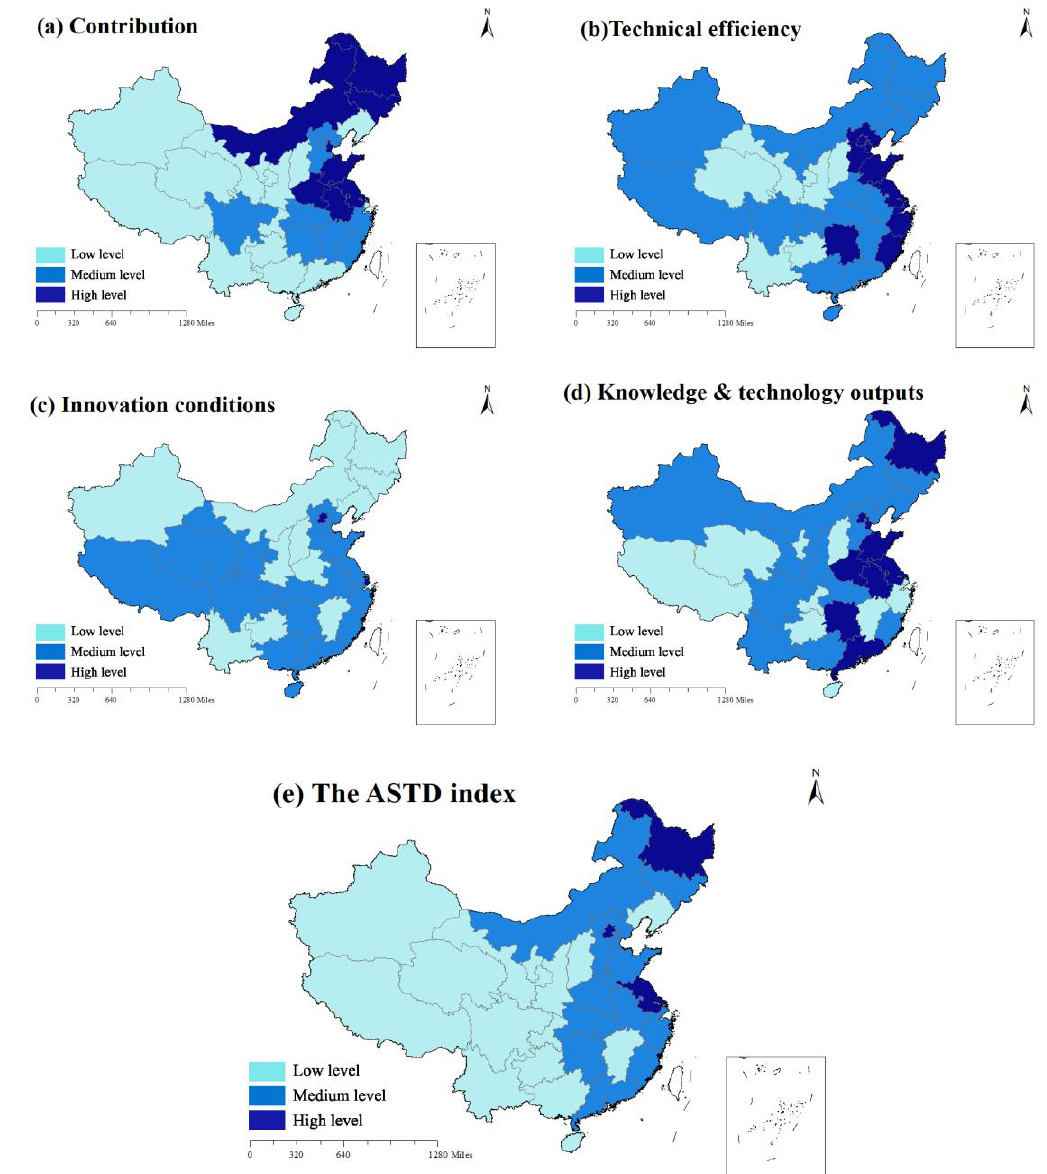
Figure 2. The classification of ASTD index and sub-pillar scores of each province in China